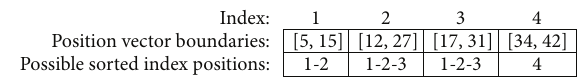
Figure 4: Possible routes after combining VBS and RK.